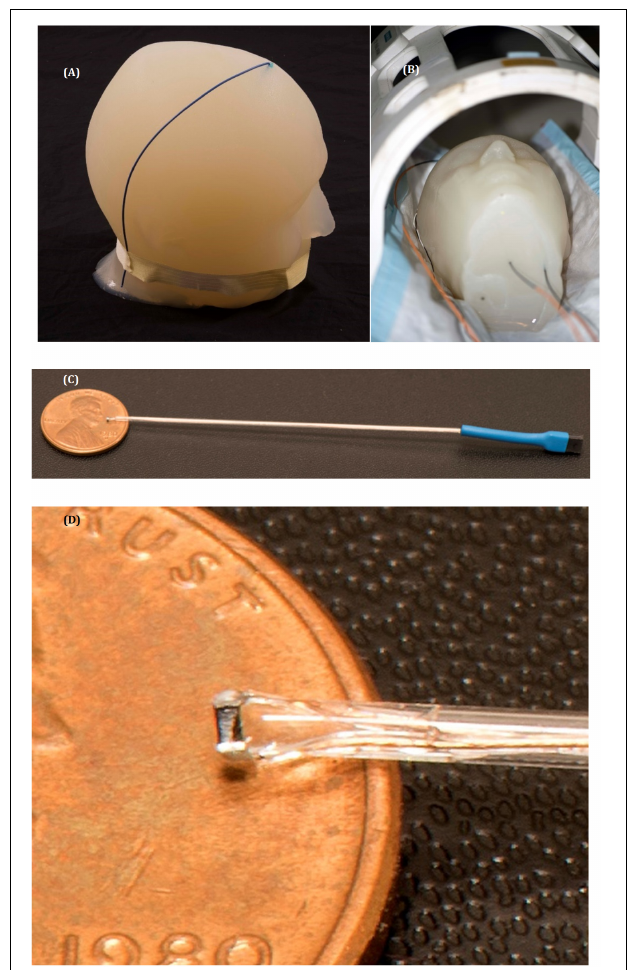
FIGURE 1 | Temperature measurements setup. (A) The gel phantom with the metal wire implanted. (B) The gel phantom with implanted µ MS coil and the fluoroptic temperature sensors inside the Tx/Rx birdcage head coil in a 1.5 T system. (C,D) Images of the µ MS implant and a detailed view of the µ MS